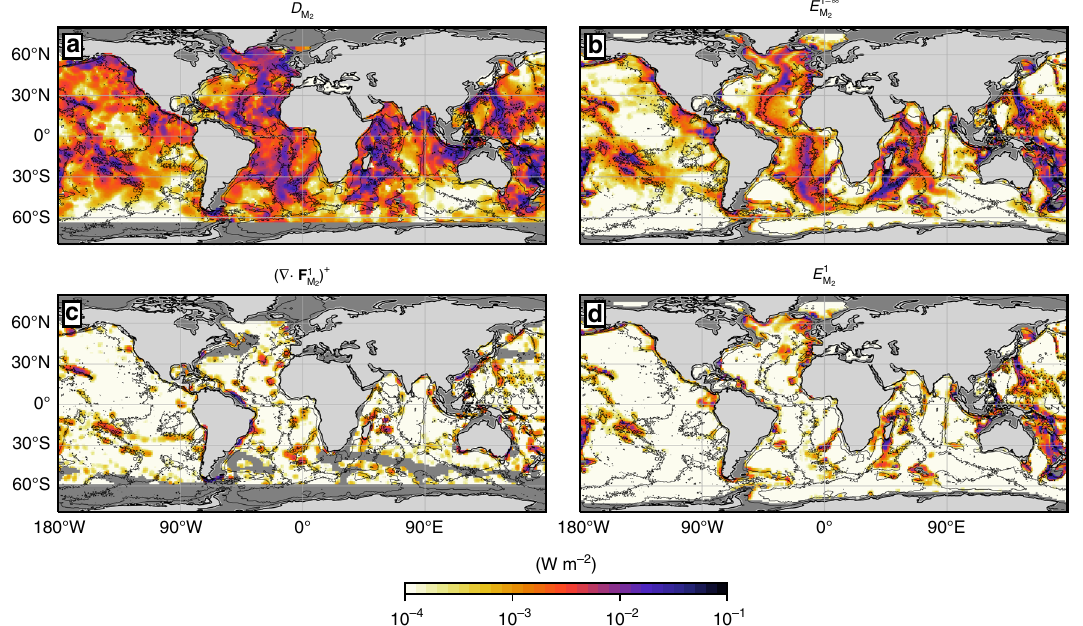
, M 2 . c Positive part of the divergence of M 2 . Areas shallower than 700 m are M 2